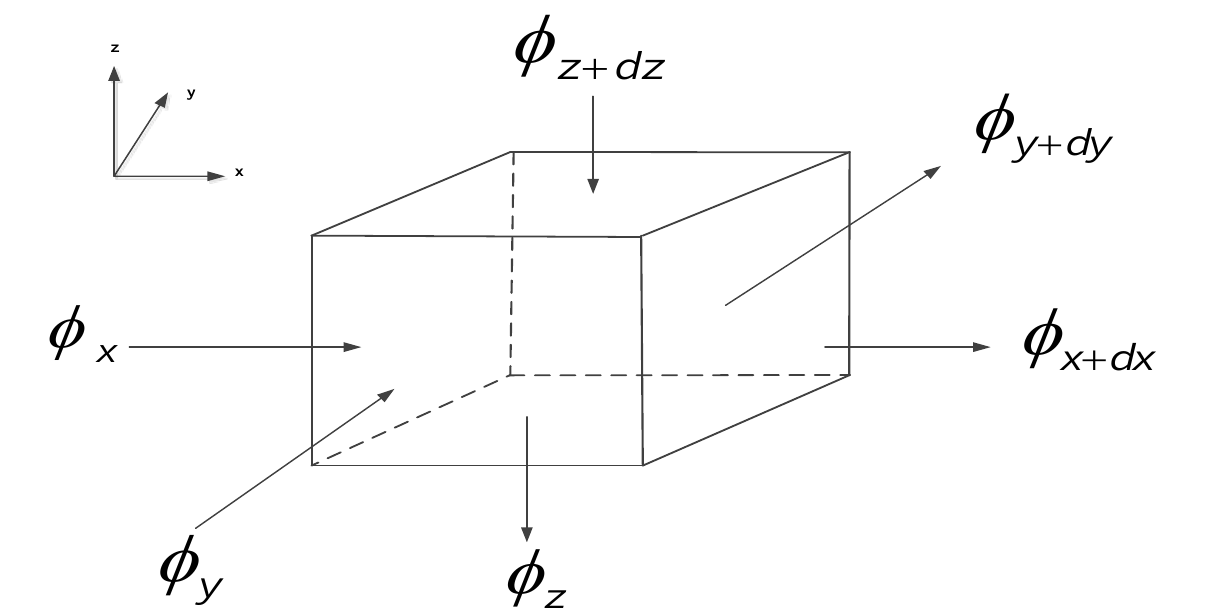
Figure 2. Schematic diagram of thermal balance analysis of